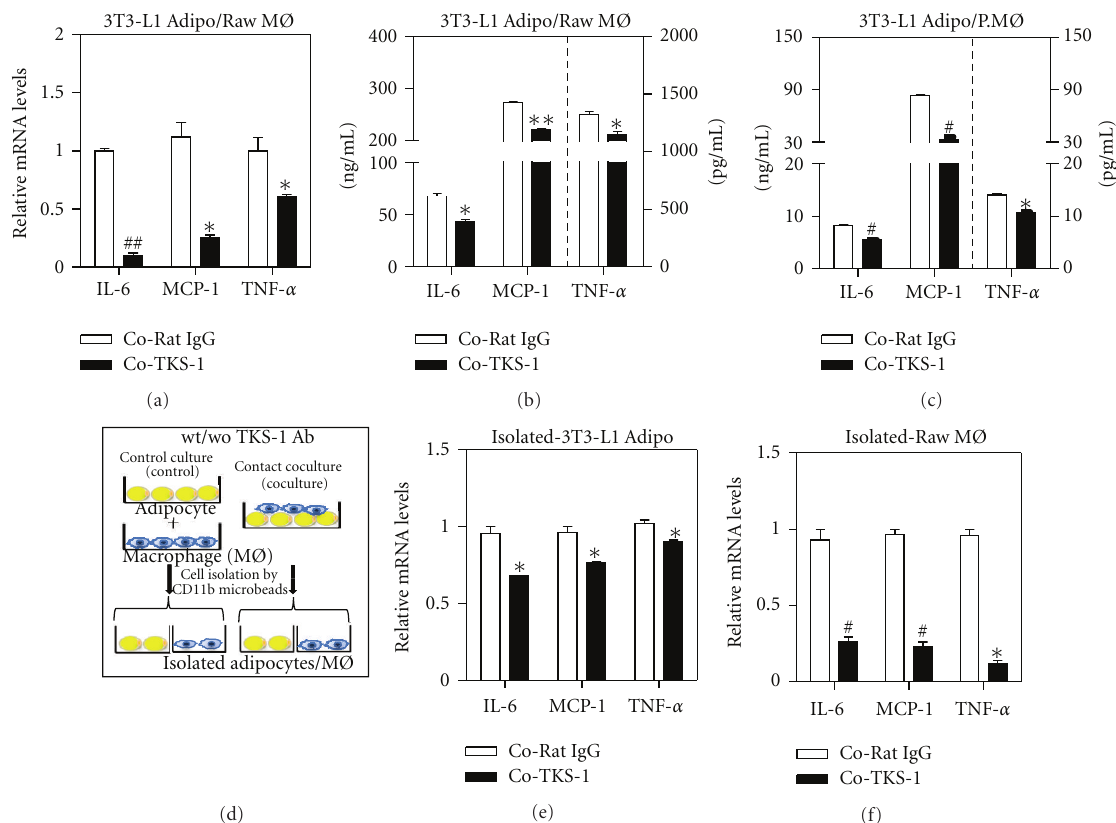
Figure 4: Disruption of the 4-1BB/4-1BBL interaction suppresses expression of inflammatory cytokines in direct contact cocultures. Raw264.7 macrophages were seeded onto 3T3-L1 adipocytes with/without pretreated with neutralizing anti-4-1BBL antibody (TKS-1) or Rat IgG (5 μ g/mL) in serum-free medium for 24 h. Total RNAs were isolated and analyzed the level of IL-6, MCP-1, and TNF- α by qRT- PCR (a). The protein levels of IL-6, MCP-1, and TNF- α in cell-free supernatants were collected from 3T3-L1 adipocytes and Raw264.7 macrophages coculture (b) and from cocultures of 3T3-L1 adipocytes and peritoneal macrophages (c). Illustration of coculture system with adipocytes/macrophages (d). After 24 h coculture of Raw264.7 macrophages and 3T3-L1 adipocytes, these cells were separated using the CD11b MicroBead system. Levels of inflammatory cytokine mRNAs were detected in the adipocytes (e) and macrophages (f). Co, coculture. Data are the mean ± SEM of three independent experiments performed in duplicate. ∗ P < 0 . 05; ∗∗ P < 0 . 01; # P < 0 . 005; ## P < 0 . 001 (compared with rat IgG-treated